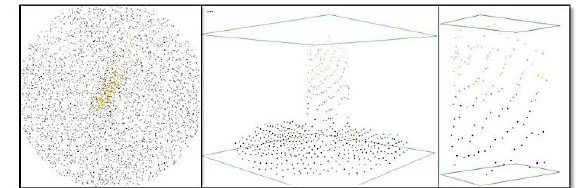
Figure 3. Illustration of the point cloud modification for the derivation of the target’s centre position.